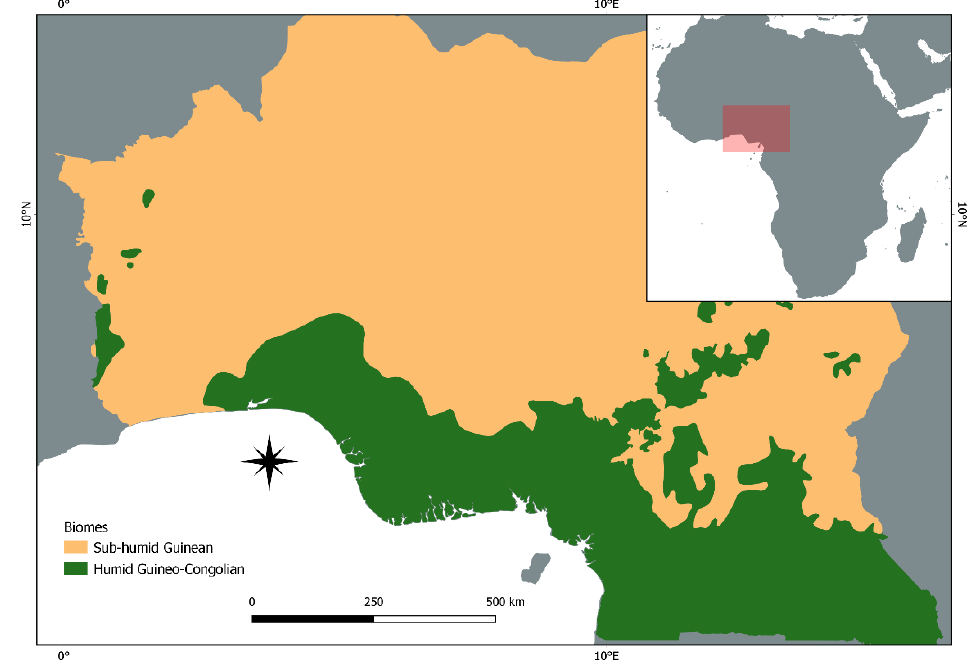
Figure 1. Study region encompassing the countries of Togo, Benin, Nigeria, and Cameroon, within the Guinean and humid Guineo-Congolian biomes.